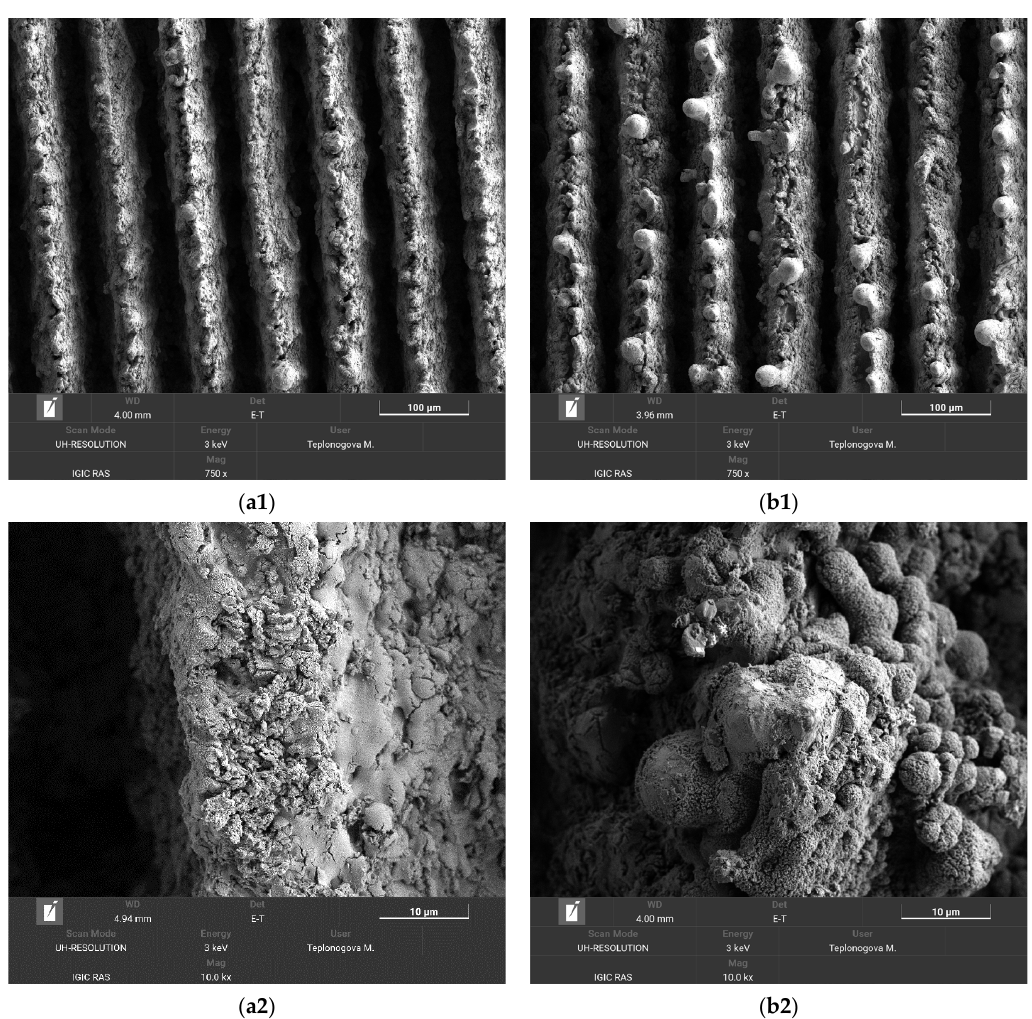
Figure 4. SEM images of the superhydrophobic tungsten sample obtained by regime 13 taken before ( a1 , a2 ) and after ( b1 , b2 ) 10 h of oscillating sand abrasion test. Scale bars: 100 μm ( a1 , b1 ) and 10 μm ( a2 , b2 ).